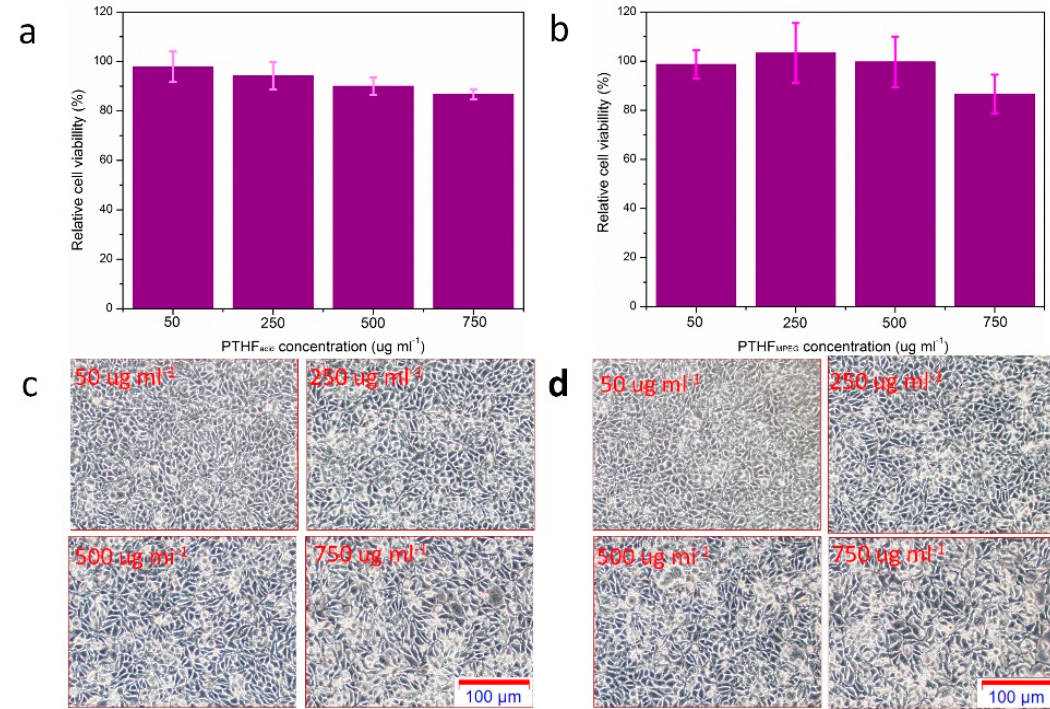
Figure 9. The cell viability of A549 cells after incubation with PTHF acid and PTHF mPEG for 24 h (PTHF acid for ( a) and PTHF mPEG for ( b ), optical microscopy images of A549 cells after incubation with different concentrations of PTHF acid and PTHF mPEG for 24 h (PTHF acid for ( c) and PTHF mPEG for ( d) ).